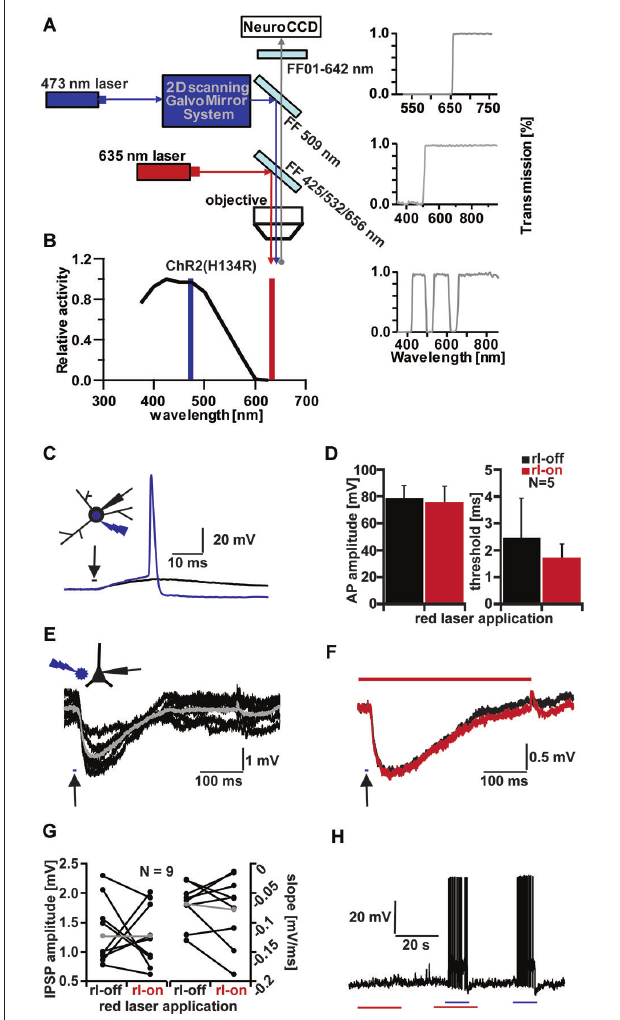
FIGURE 1 | Channelrhodopsin (ChR) activation and influence of red laser (rl) application. (A) Schematic drawing of optical system for combined VSD imaging and ChR2 activity modulation. (B) ChR2 light excitation spectra (adapted from Gradinaru et al., 2010). Blue line indicates wavelength of 473 nm-laser application, red line indicates 635 nm-laser application. (C) Testing threshold of ChR2+ interneurons activation by increasing light duration (in 0.1 ms increments) applied to soma with below threshold (black trace, 2.5 ms) and above threshold duration (blue trace, 2.6 ms; Vm = − 55 mV); inset shows light application configuration on patched Stratum radiatum interneuron. (D) Influence of rl intensity used for VSD imaging on AP amplitude and light duration threshold of five ChR2+ interneurons. Average amplitude (left bar graph): 78.41 ± 9.77 mV (rl-off, black), 75.2 ± 12.21 mV (rl-on, red). Average threshold (right bar graph): 2.46 ± 1.46 ms (rl-off, black), 1.68 ± 0.56 ms (rl-on, red). (E) Evoked IPSPs in a CA1 pyramidal cell by 10 ms blue light application (arrow) next to cell in layer pyramidale (schematic inset). Averaged IPSP (gray; ∆ IPSP = 2 mV) of 6 traces (black; Vm = − 60 mV). (F) Comparison of evoked IPSPs without (black trace, average of 8) and with rl (red trace, average of 9) application (Vm = − 61 mV, ∆ IPSP = 1.2 mV). (G) Influence of rl application on IPSP amplitude (left bar graph) and slope (right bar graph) of CA1 pyramidal cells. Average IPSP amplitude (gray): 1.27 ± 0.5 mV (rl-off, left), 2.3 ± 1.99 mV (rl-on, right). Average slope (gray): − 0.07 ± 0.04 mV/ms (rl-off, left), − 0.18 ± 0.2 mV/ms (rl-on, right). (H) Influence on membrane potential (Vm = − 62 mV) of ChR2+ interneuron with red (red line, 20 ms) and blue laser (blue line, 10 ms)